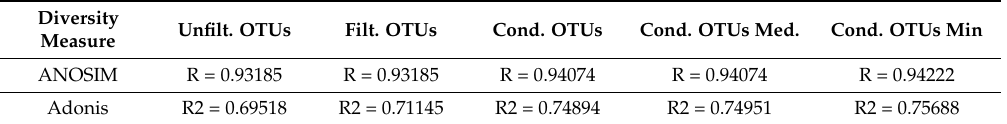
Table 2. Grouping statistics performed on each OTU table generated in the study. Results show both ANOSIM and Adonis measurements of the initial OTU table (unfiltered; Unfilt.), followed by filtering of those taxa represented at <0.0005% in the study (filtered; Filt.), condensing (Cond.) using PhyloToAST (v1.4.0) and rarefying to the median (Med.) and minimum (Min.) of the condensed OTU table file. Analysis was performed on grouped biological sample replicates (pharynx, n = 3; gut tissue, n = 3; gut digesta, n = 3; water, n = 3; and algae, n = 3). Diversity Unfilt. Measure